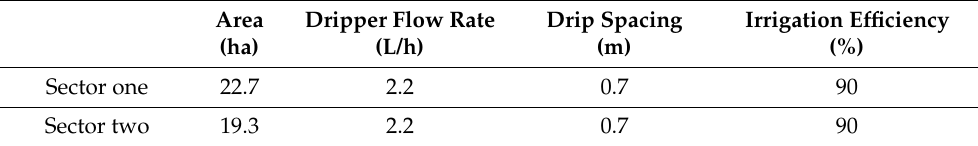
Figure 1. Annual precipitation and ET 0 data recorded at the Cordoba agroclimatic station belonging to the RIA, from 2001 to 2021. Table 2. Characteristics of the irrigation sectors. Sector one with the Arbequina variety and sector two with the Arbosana